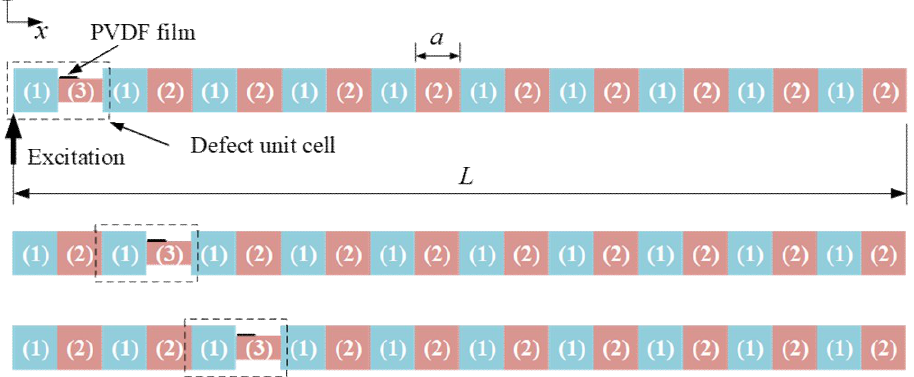
Figure 1. Schematic diagram of the phononic crystal (PC) beam with a mismatched segment (color online).